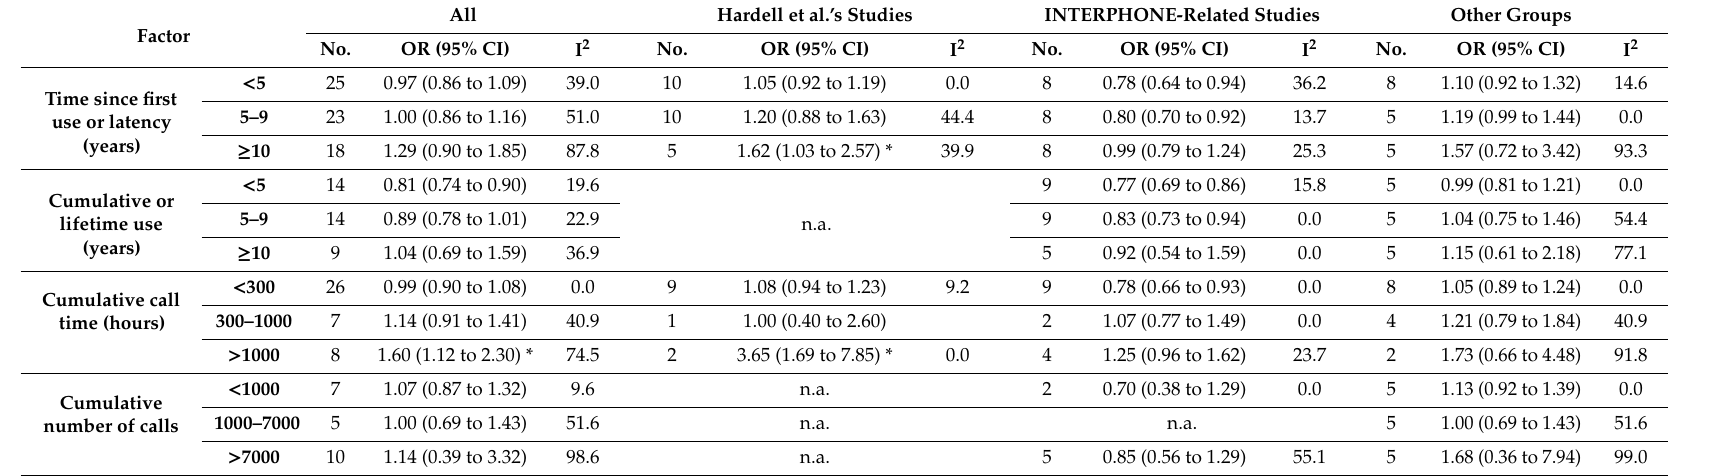
Table 3. Exposure–response relationship between use of cellular phones and risk of